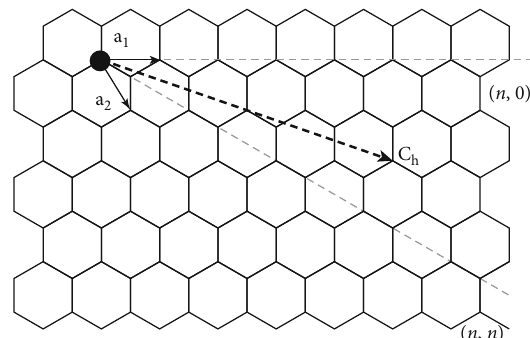
Figure 1: Two-dimensional representation of lattices of SWCNT.